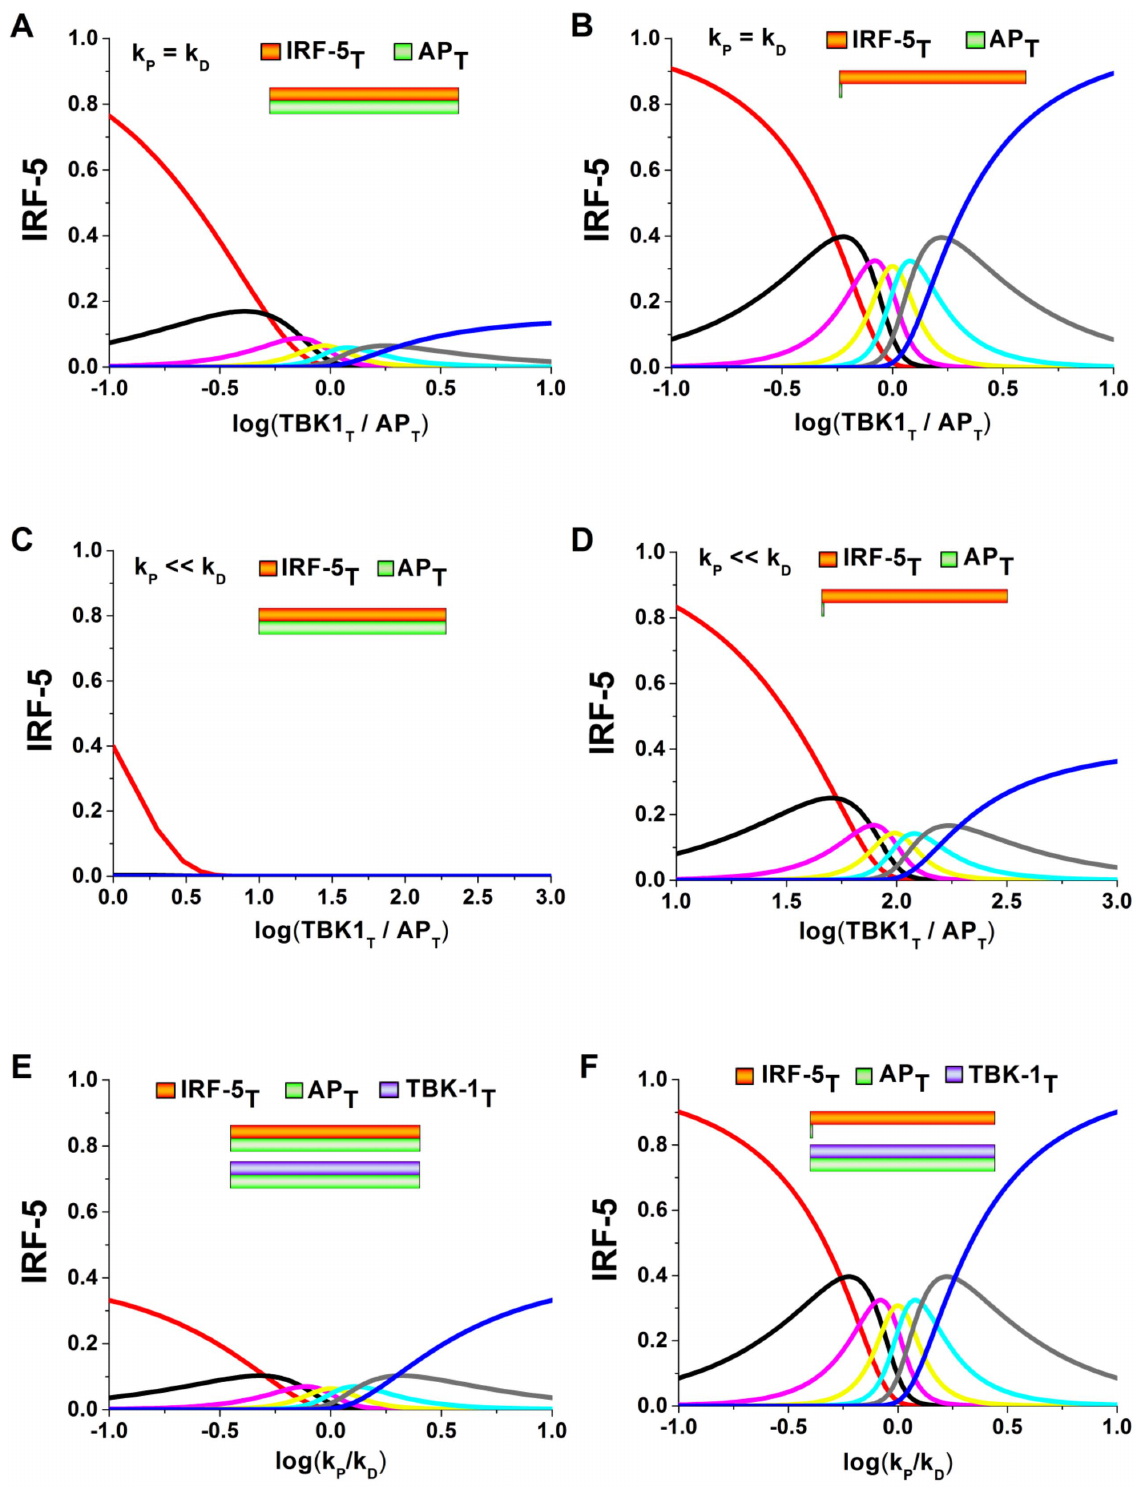
Figure 4. Theoretical investigation of the regulation of IRF-5 multisite phosphorylation. The distribution of IRF-5 species was investigated as a function of kinase to phosphatase (TBK to AP) ratio for comparable IRF-5 and AP concentrations (A), IRF-5 significantly exceeds AP (B). Similar analysis was also performed when the phosphorylation rate was significantly lower than dephosphorylation rate and comparable IRF-5 and AP concentrations (C), IRF-5 significantly exceeds AP (D). The effects of changes in the phosphorylation to dephosphorylation ratio on the IRF-5 species were also investigated with comparable IRF-5 and AP concentrations (E), IRF-5 significantly exceeds AP (F). The presented analyses clearly show that the phosphorylation/dephosphorylation parameters, modulated via extracellular cytokines have prominent impact on the distribution of phosphorylated species. Therefore, physiological or pathological alterations of these parameters represent the multisite phosphorylation-mediated mechanism of T cell plasticity. doi:10.1371/journal.pone.0110913.g004 PLOS ONE |